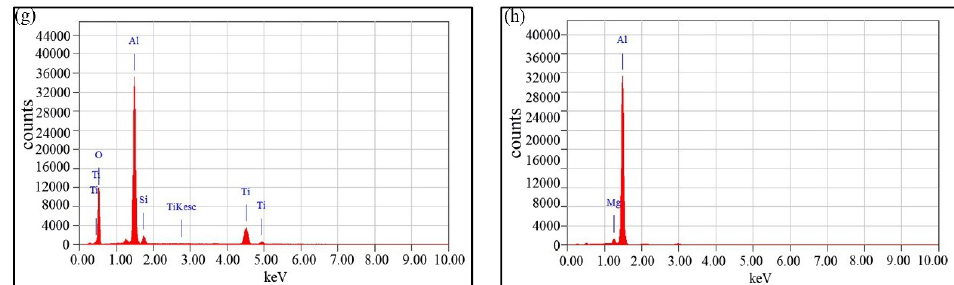
Figure 5. The energy dispersive spectroscopy (EDS) analysis of MAO coating surfaces before and after test. ( a ) Figure 4a; ( b ) Figure 4b; ( c ) Figure 4c; ( d ) Figure 4d; ( e ) Figure 4e; ( f ) Figure 4f; ( g ) Figure 4g; ( h ) Figure 4h.